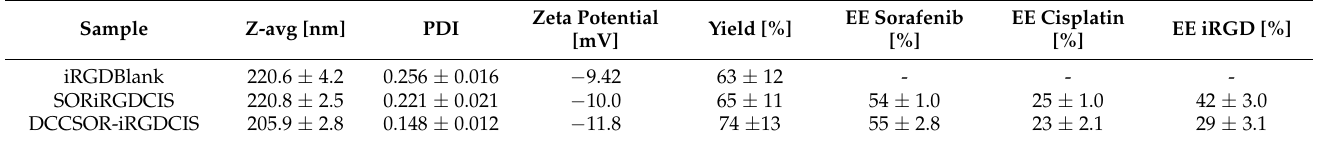
Figure 4. Particle size distribution of dual drug and iRGD-loaded nanoparticles with (DCCSORiRGDCIS) and without DCC (SORiRGDCIS).